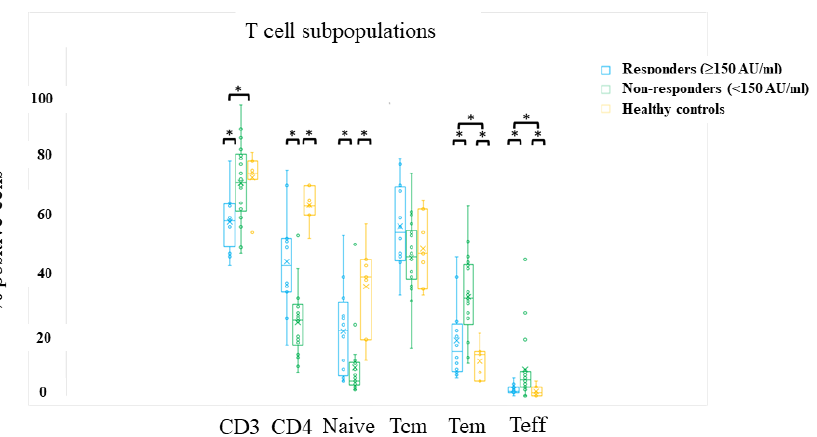
Figure 2. T-cell sub-populations. Comparing the abundance of T cells, T helper cells, and T helper subpopulations in vaccine responders ( n = 12), non-responders ( n = 18), and healthy controls ( n = 7). Samples are from three to six months after the second vaccine dose. * denotes a significant difference between two compared populations ( p < 0.05). Values are presented in Table S1. Tcm—T central memory; Tem—T effector memory; Teff—T effectors. As for the levels of central memory CD4 T cells, they were similar in the three groups, but the abundance of T effector memory cells and T effectors was significantly higher in non-responders. All the three cell subpopulations, T helper, T central memory, and T effector memory, demonstrated a very strong response to PHA. Furthermore, all of them expressed significantly elevated levels of the activation markers in responding patients and healthy controls relative to non-responders (Figure